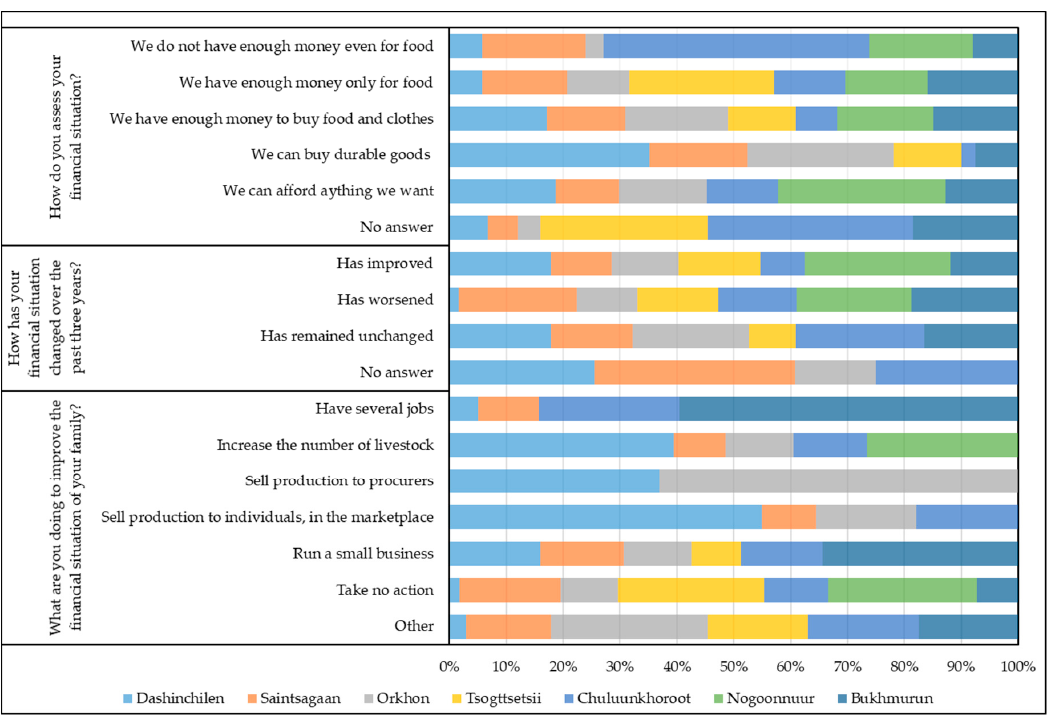
Figure 5. Distribution of answers to questions about the household’s financial situation.